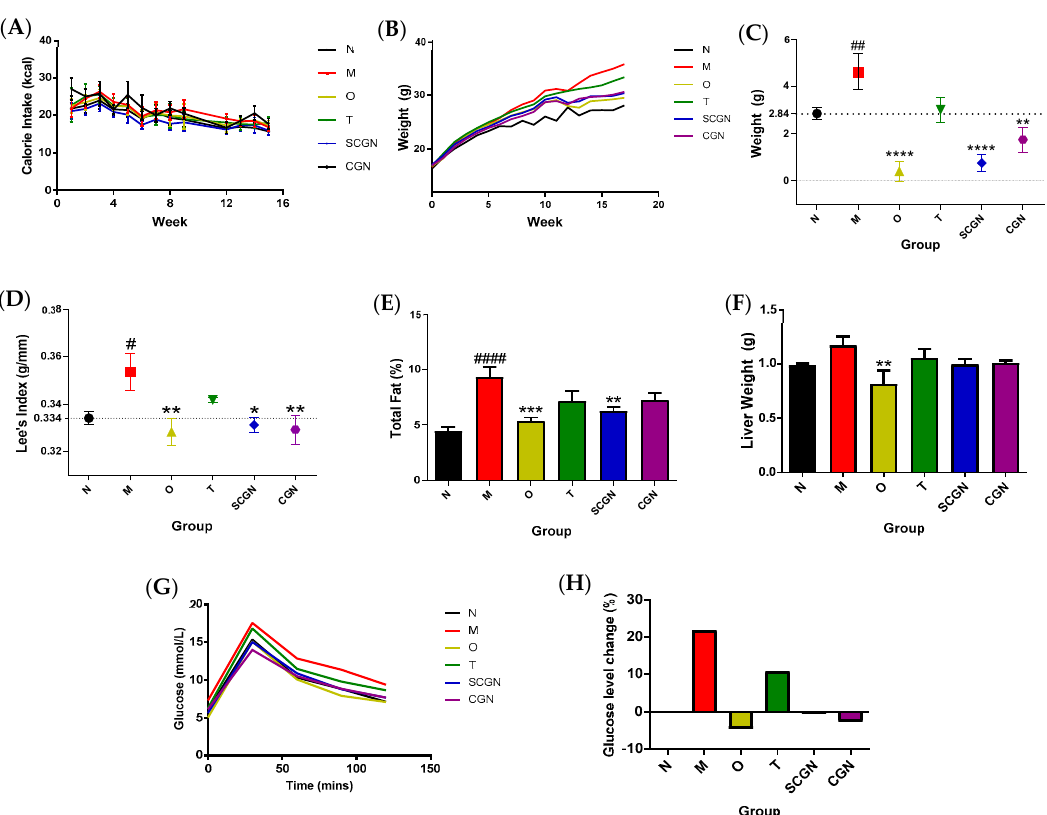
Figure 1. The effects of diet on phenotype of overweight C57BL/6J mice: ( A ) Energy intake throughout the experiment, ( B ) body weight fluctuations, ( C ) accumulated weight changes after dietary intervention, ( D ) Lee’s obesity index, ( E ) total fat percentage, ( F ) percentages of liver weight changes relative to N, ( G ) oral glucose tolerance test (OGTT), ( H ) AUC of OGTT relative to N. N = Normal, M = Model, O = Orlistat, T = Whole Kappaphycus , CGN = Carrageenan, SCGN = Sans-carrageenan fraction. Values are given as mean ± SEM, n = 7–8. Statistical significances were calculated using one-way or two-way ANOVA with Tukey post-test where appropriate (* and # p < 0.05, ## and ** p < 0.01, *** p < 0.0005, #### and **** p < 0.0001); # denotes versus N, * denotes versus M.